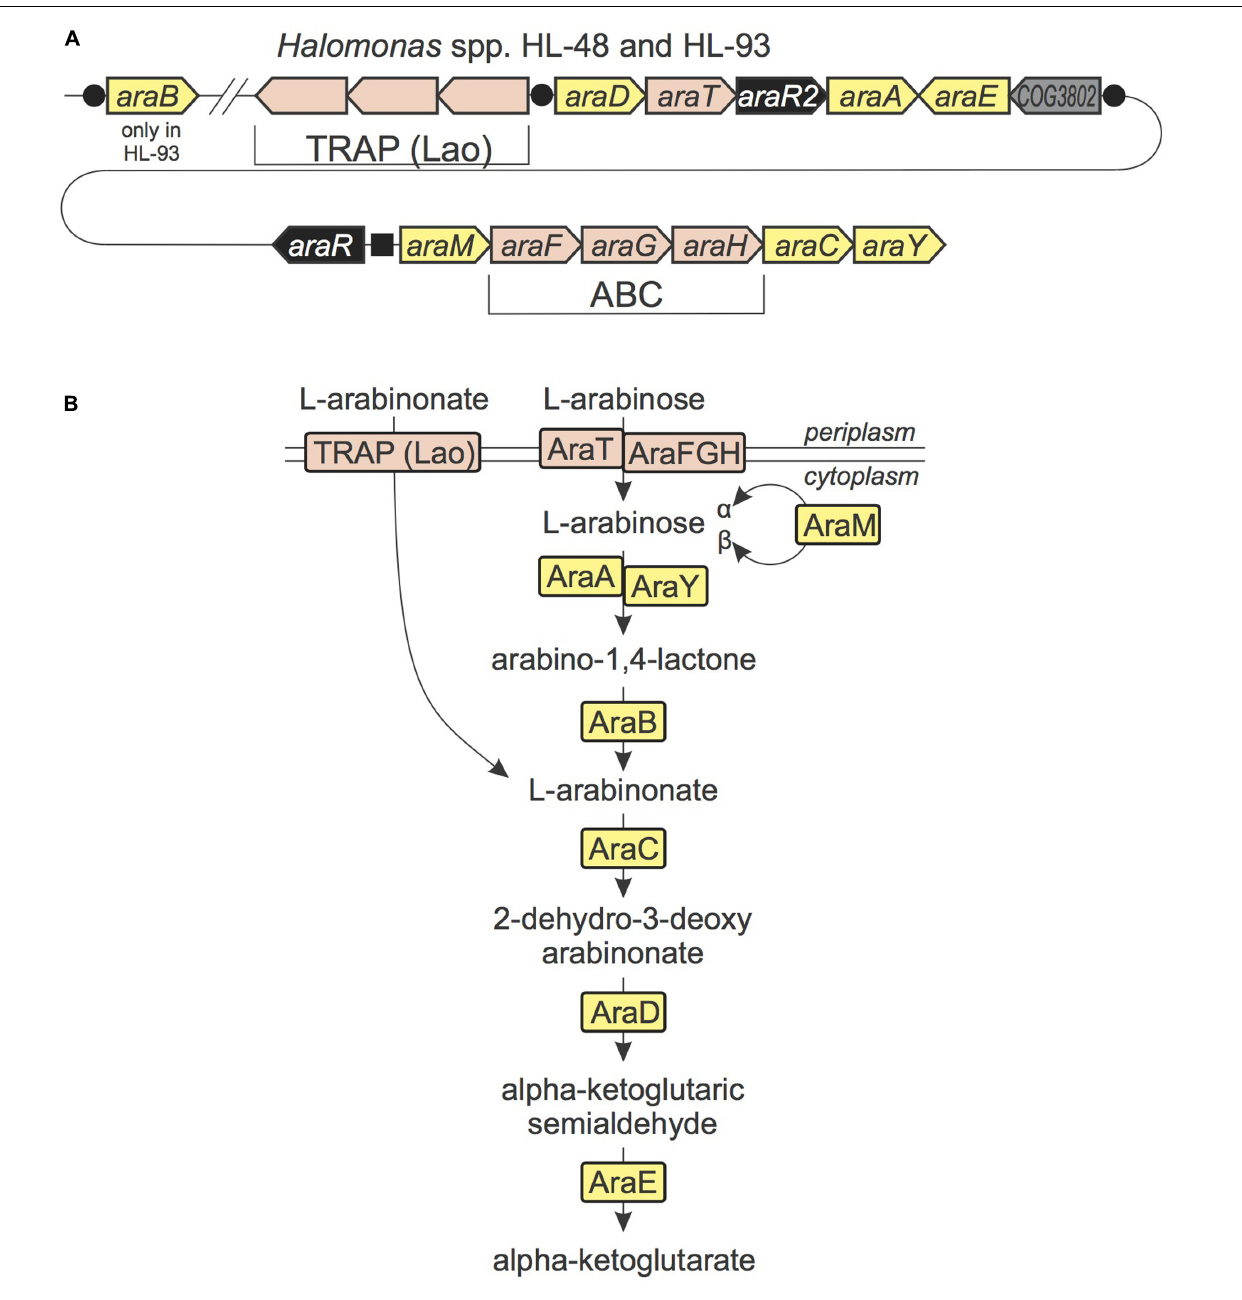
FIGURE 2 | L -Arabinose and L -arabinonate utilization in Halomonas species. (A) The conserved locus in HL-48 and HL-93 genomes containing genes from L -arabinose and L -arabinonate utilization pathways. Genes are colored by their general functional roles: enzymes (yellow), transcription factors (black), transporters (pink), uncharacterized genes (gray). Candidate TF binding sites are shown as black circles (for AraR2) and a black square (for AraR). (B) Scheme of L -arabinose and L -arabinonate utilization pathways in Halomonas spp. Enzymes are colored by matching colors as in (A) .